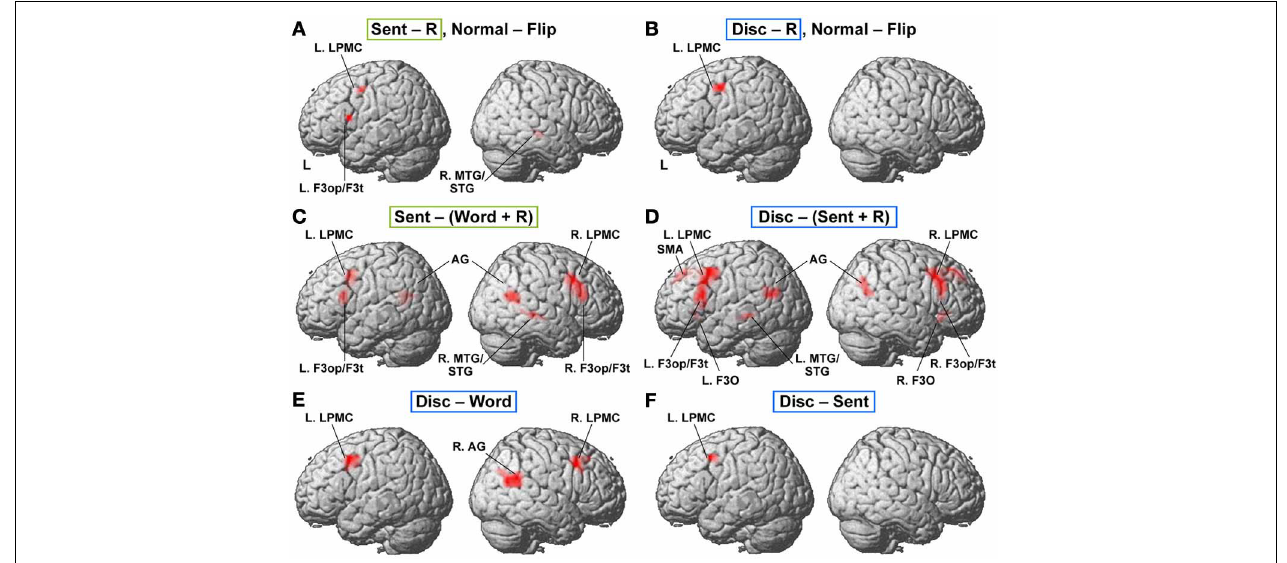
FIGURE 3 | Lateralization and functional localization of cortical activations. (A,B) Cortical activations in the Sent − R or Disc − R of the brain images flipped from side to side (Flip) were subtracted from those of the normal images (Normal). In Sent − R, Normal − Flip (A) , note the significant effect of hemispheres in the L. LPMC, F3op/F3t,